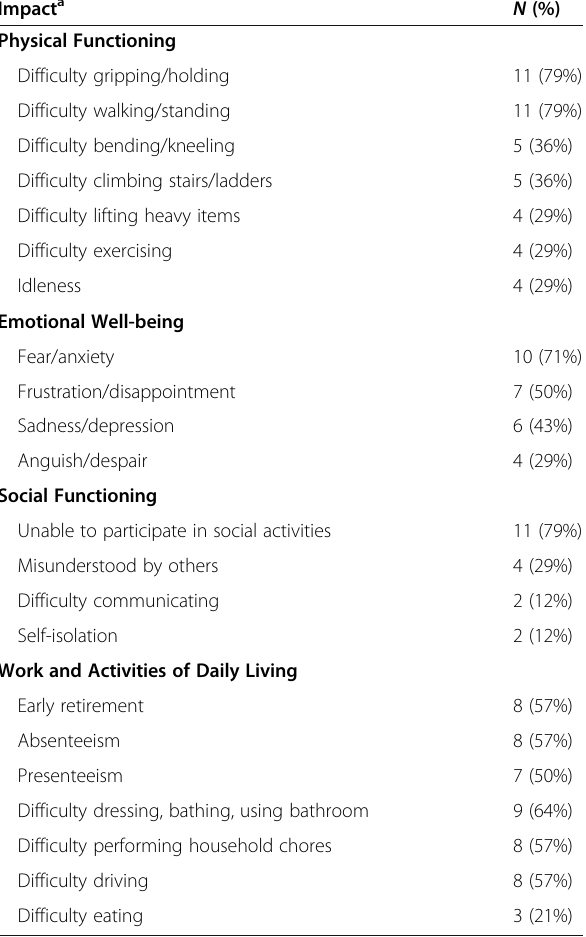
Table 4 Impacts of hATTR Amyloidosis on patients ’ functioning and